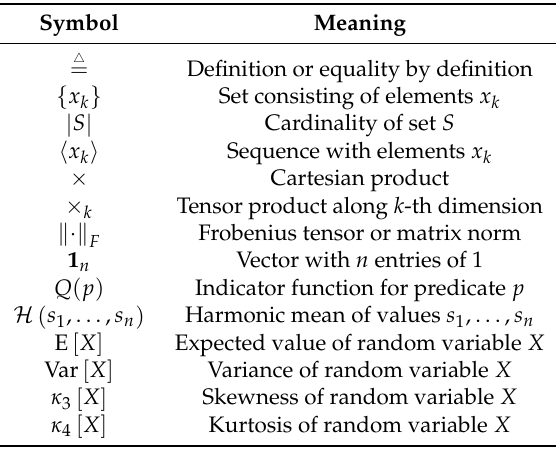
Table 1. Article